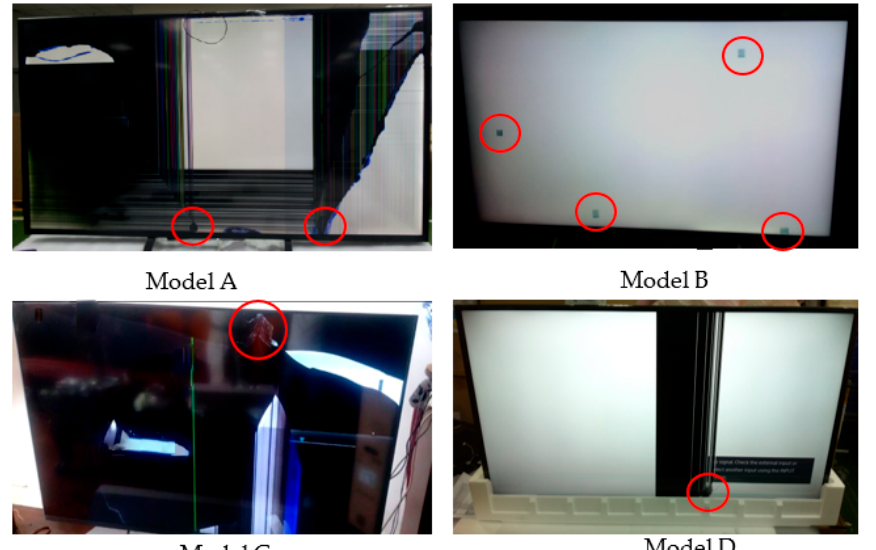
Figure 6. Drop test result.